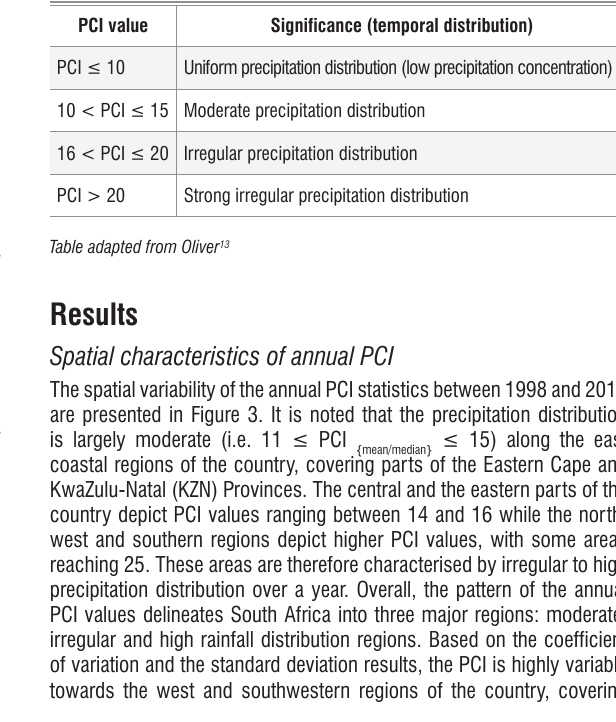
Classification of precipitation concentration based on preci-